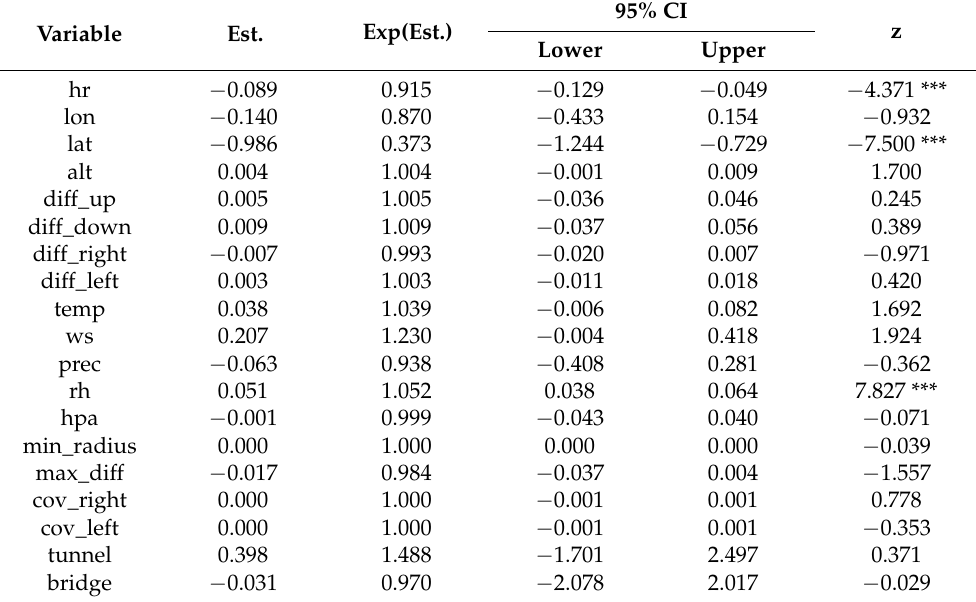
Table 4. The summary of logistic regression model.